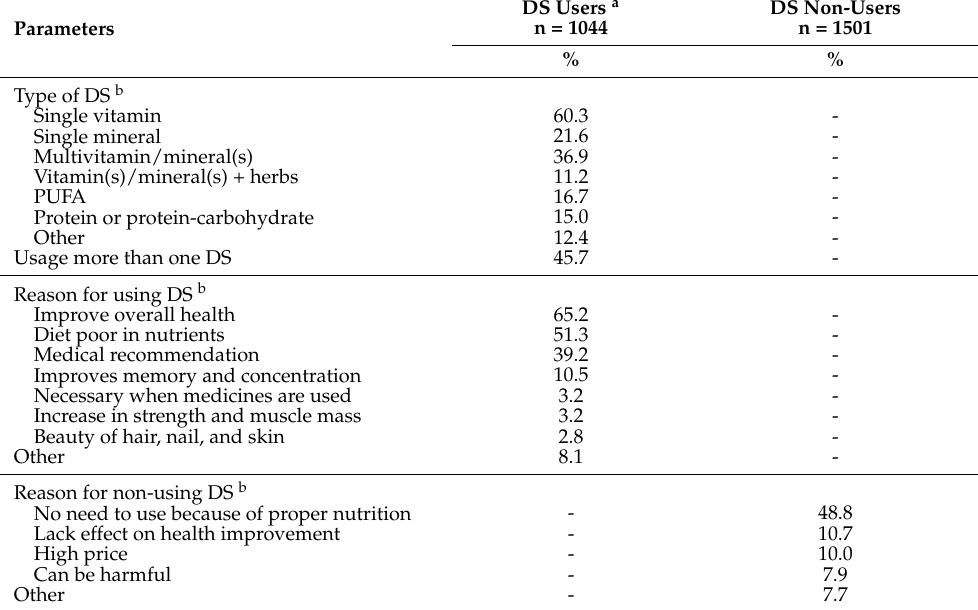
Table 2. The prevalence of specific types of dietary supplement use and reasons for using or non-using them by university students (n =